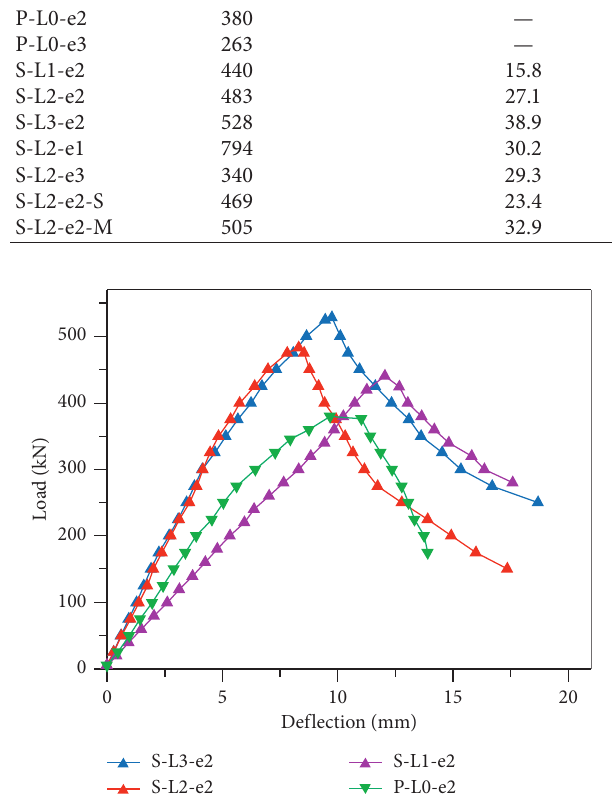
Figure 5: Load-lateral deflection curves of eccentrically loaded columns with different grid layers.